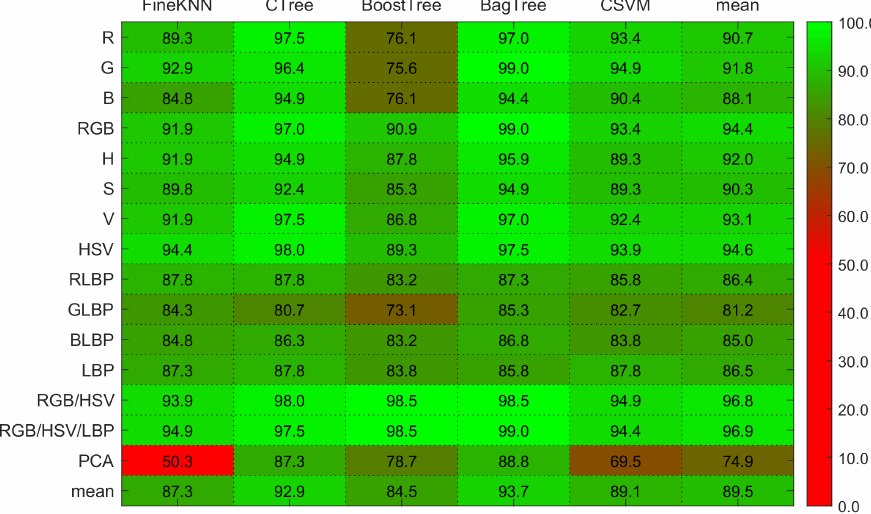
Figure 6. Illustration of heat-maps accuracy comparison using RGB histogram, HSV histogram, LBP and hybrid feature vectors for Guava disease